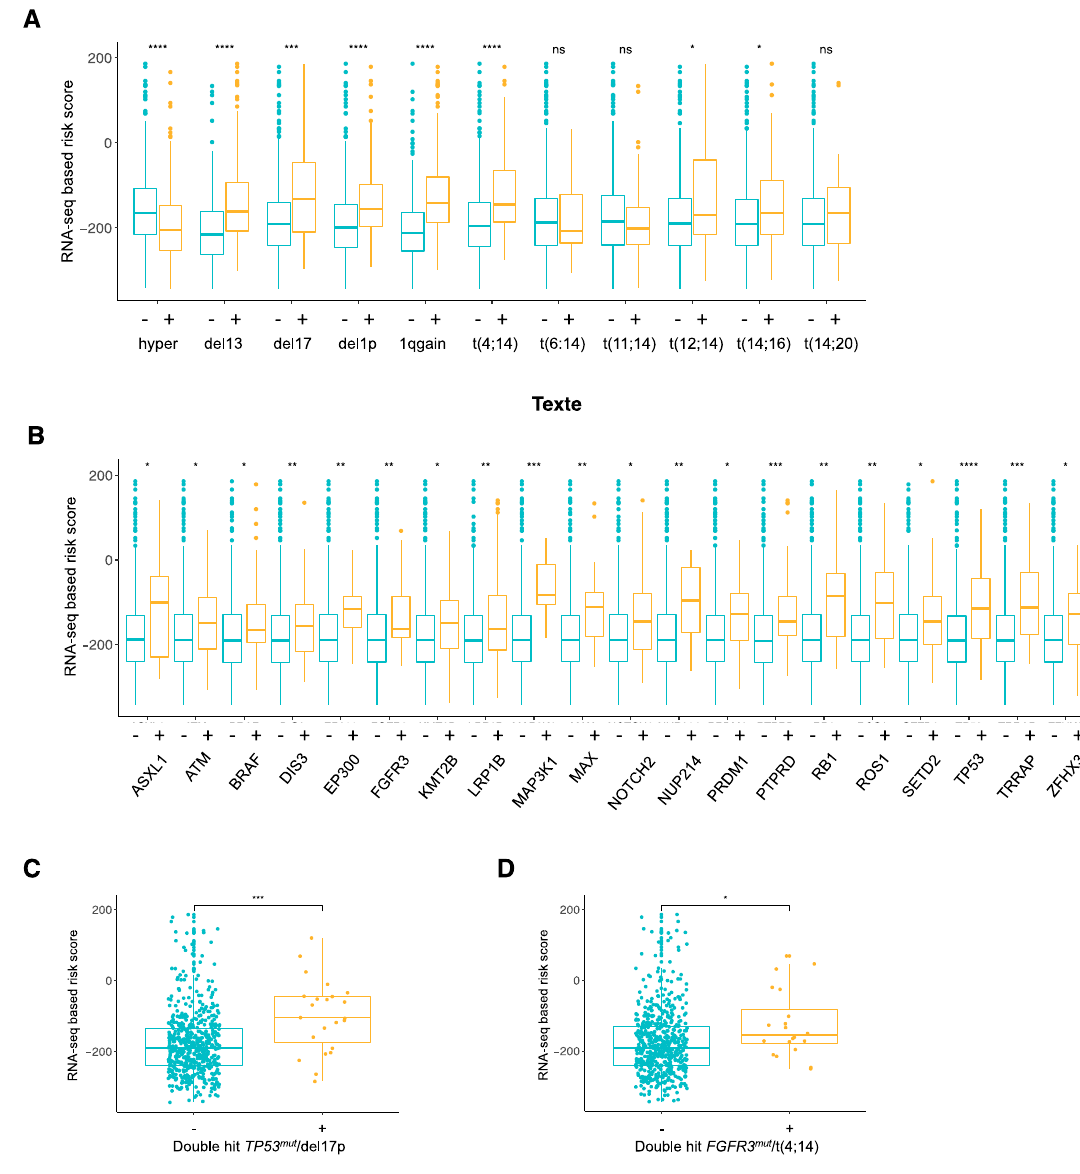
Figure 3. Association between RNA-seq-based risk scores and cytogenetic abnormalitie subgroups and mutations in MM patients from the CoMMpass cohort. ( A ) RNA-seq-based risk score in cytogenetic abnormality subgroups. Cytogenetic abnormality subgroups were composed of hyperdyploid (without: n = 240, with: n = 331), del(13p) (without: n = 307, with: